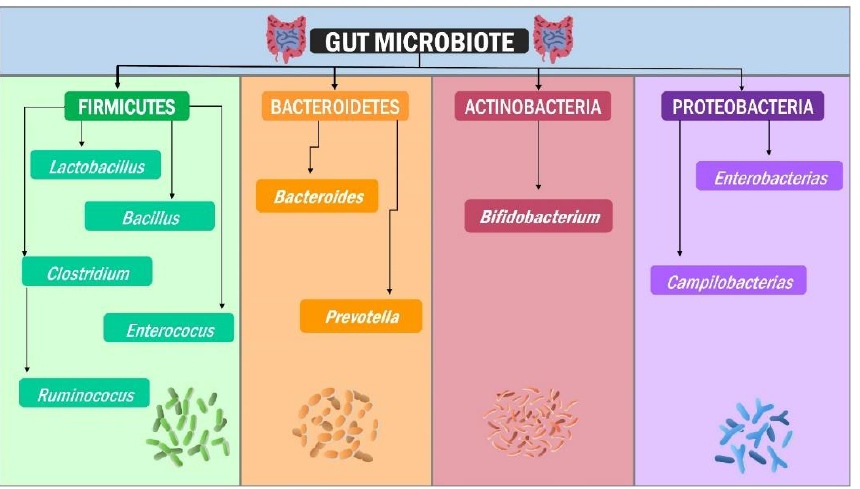
Figure 1. Gut microbiota composition: Firmicutes , Bacteroidetes , Actinobacteria , and Proteobacteria are the four “standard” Phyla in our gut intestinal microbiota. Each phylum comprises bacteria with diverse structures, metabolism, and functions.